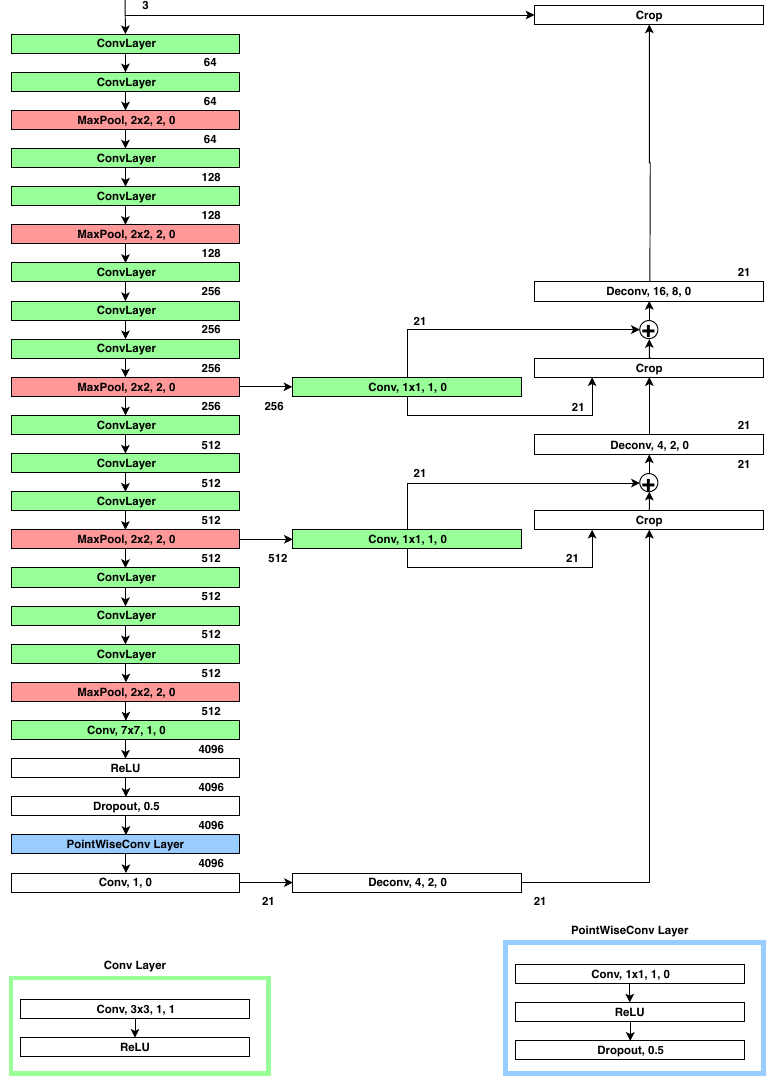
Figure A3. FCN-8s as introduced by Long et